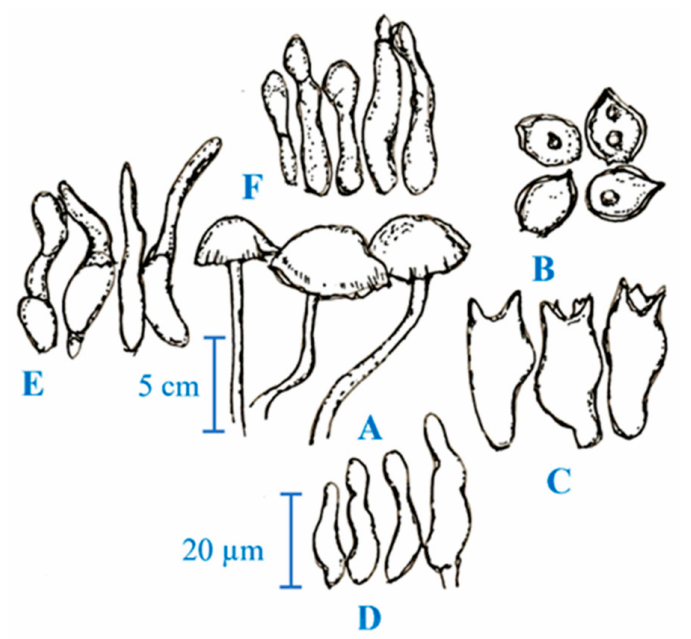
Figure 2. Panaeolus paplilionaceus var. parvisporus. ( A ) Carpophore; ( B ) basidiospores; ( C ) basidia; ( D ) caulocysitidia; ( E ) pileocysitidia; ( F )